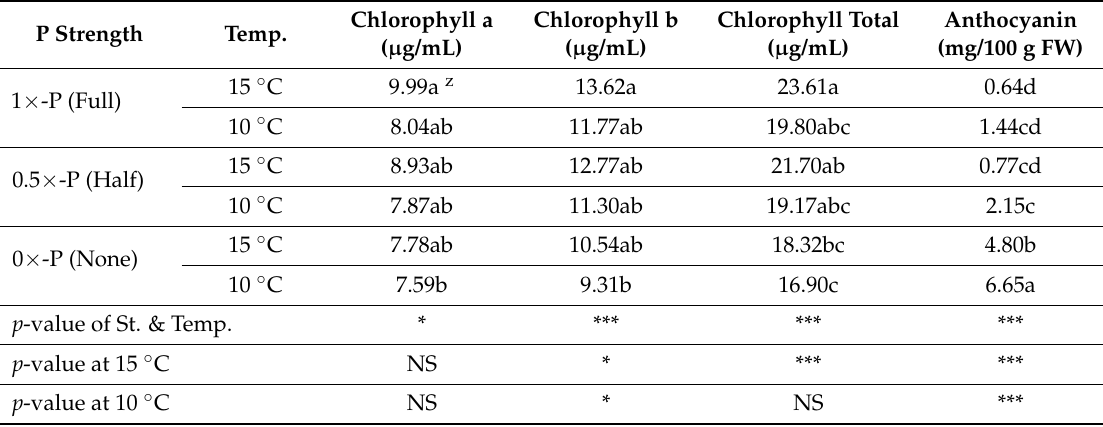
Table 7. Chlorophyll (chl a, chl b and chl total) and anthocyanin content after harvest (28 days after treatment at 20 ◦ C) of red romaine